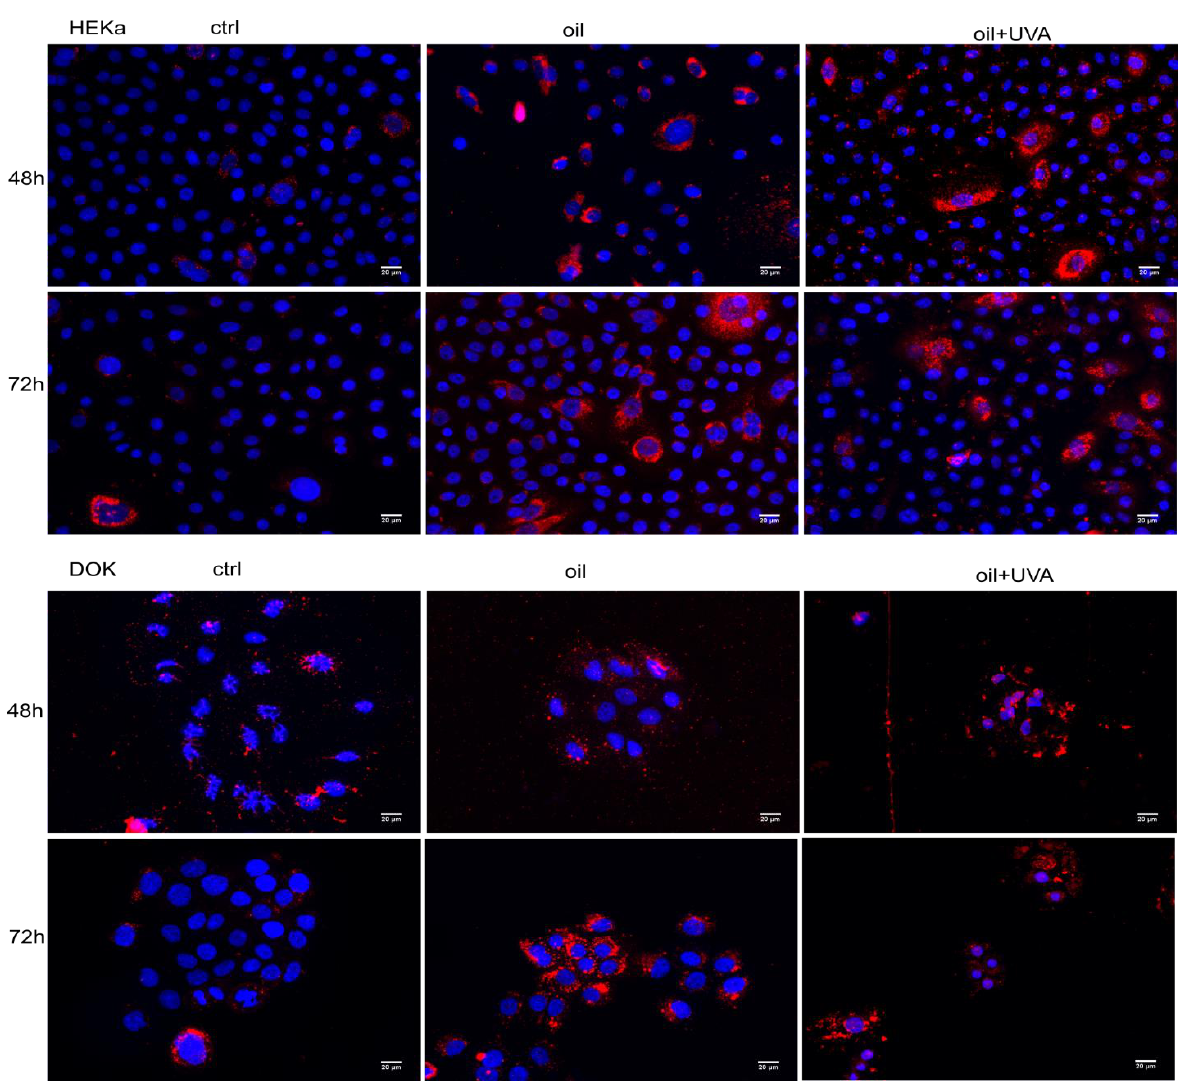
Figure 5. Oil uptake in irradiated and non-irradiated cells. Irradiated and non-irradiated cells were treated with sea-buckthorn seed oil (dilution 1/8000) for the indicated periods of time. Non-treated, non-irradiated cells were used as controls. Lipid inclusions were stained with Oil Red O.